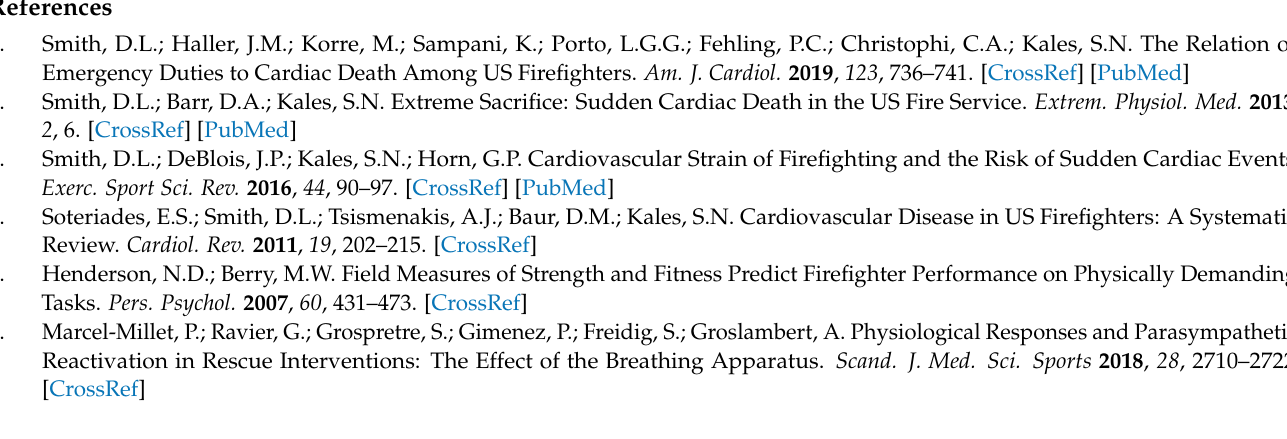
Table S1. critical appraisal of cross-sectional studies (adapted from the appraisal tool for cross-sectional studies checklist); Table S2: Critical Appraisal Skills Programme of cohort and case-controlled studies (adapted from the Critical Appraisal Skills Programme). Supplementary File S5: Figure S2C: Funnel plot for publication bias; Figure S2D: Funnel plot for publication bias; Figure S3C: Forest plot for publication bias; Figure S3D: Forest plot for publication bias; Figure S4C: Forest plot for publication bias; Figure S4D: Forest plot for publication bias; Figure S5D: Forest plot for publication bias; Figure S5E: Forest plot for publication bias; Figure S5F: Forest plot for publication bias; Figure S6B: Forest plot for publication